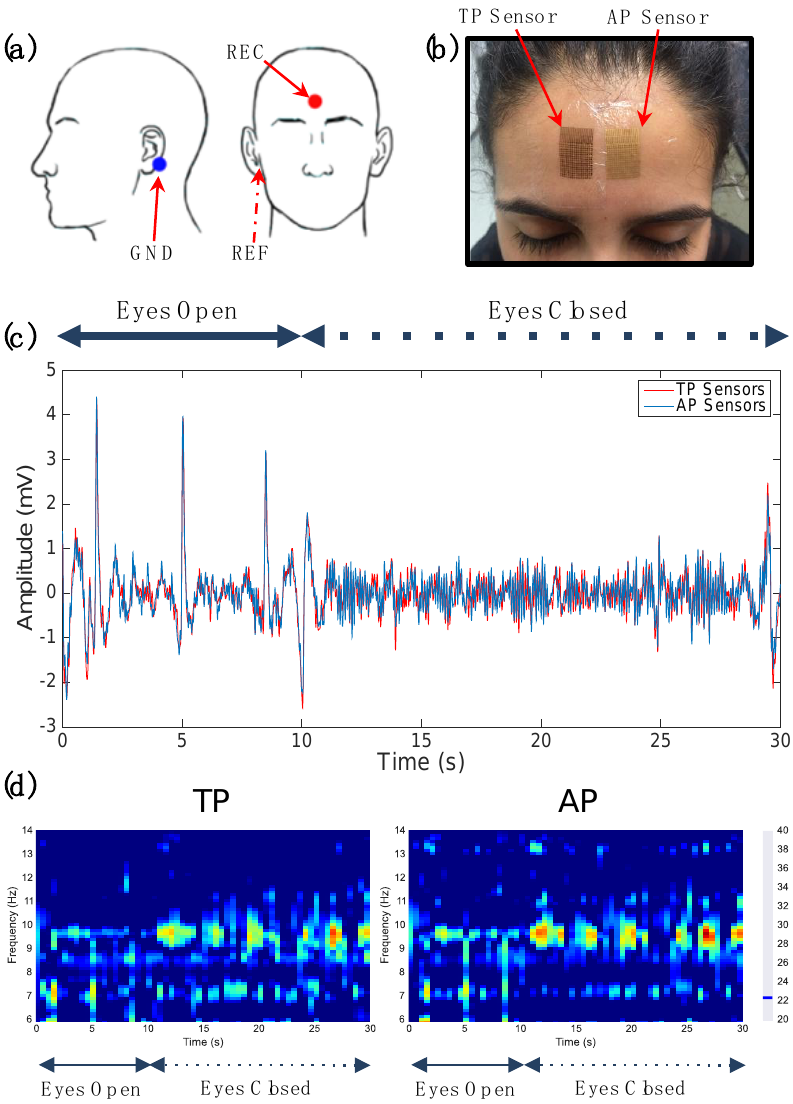
Figure 6. Electrophysiological comparison of sensors: ( a ) EEG testing electrode montage; ( b ) sensors applied to acquisition site—TP on the left, AP on the right; ( c ) time−voltage plot for one epoch of data: red = TP, blue = AP; and ( d ) spectrographic representation of epoch: TP on the left, AP on the right. The alpha rhythm begins just after the 10 s mark for both